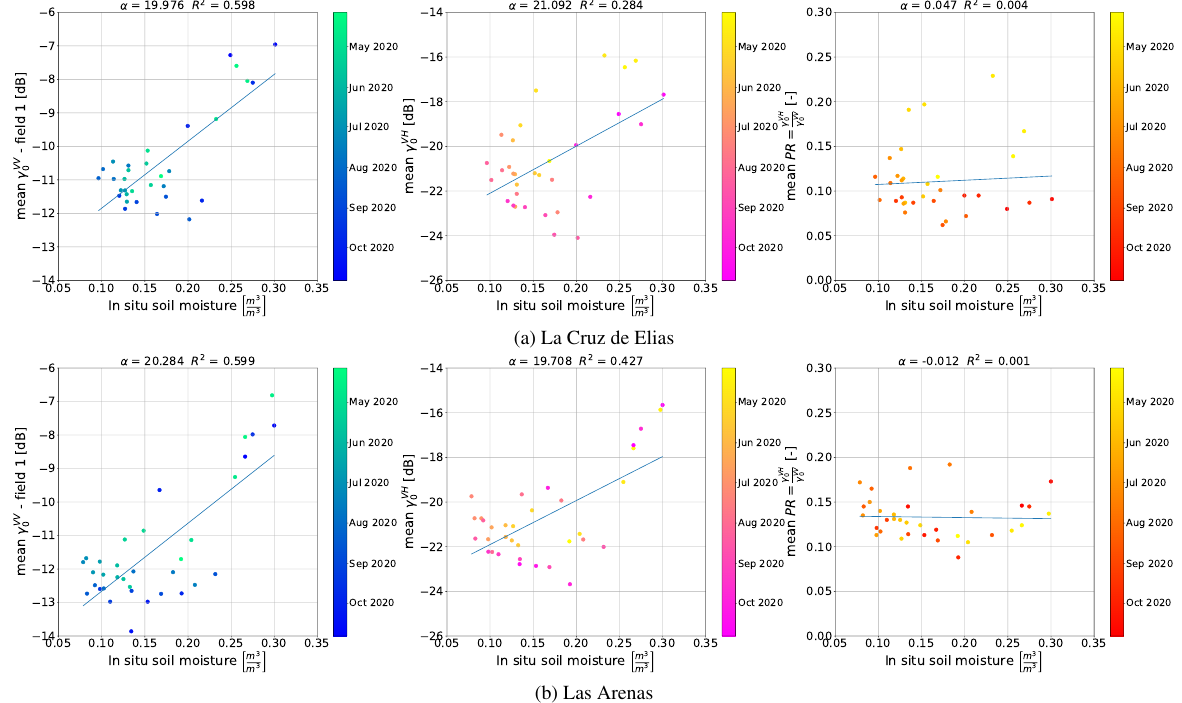
Figure 4. Comparison between superficial soil moisture in m 3 /m 3 and SAR parameters for the field 1 of 4a) La Cruz de Elias and 4b) Las Arenas. For all the SAR parameters γ V V 0 in dB, γ V H 0 in dB and PR are reported the slope α of the fitting straight line and the coefficient of determination R 2